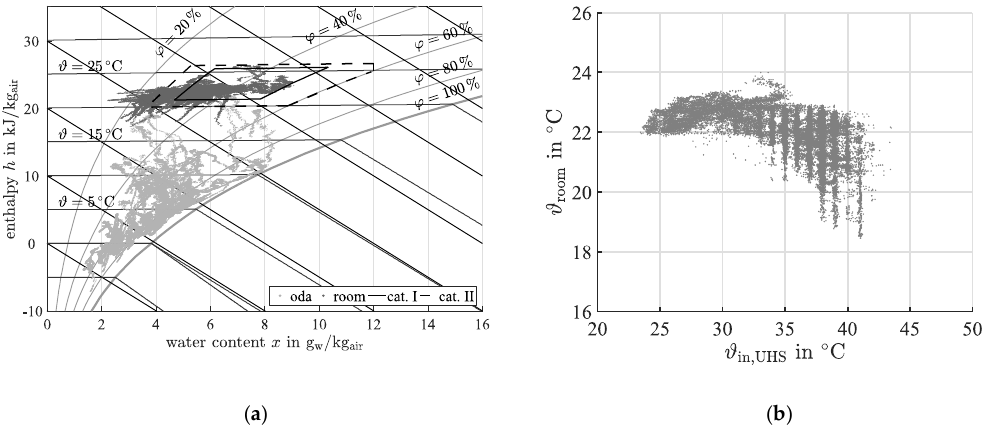
Figure 10. ( a ) Outside and room air conditions during system operation for the investigated heating period; ( b ) dependence of room air temperature on underfloor heating inlet